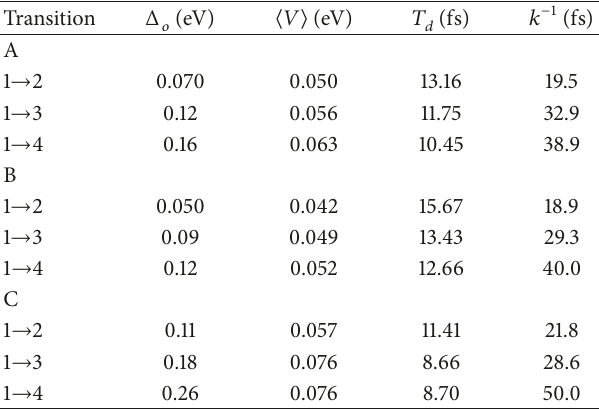
Table 1: Estimated excited state (𝑖 → 𝑓) transition rates and vibronic couplings for simulations A, B, and